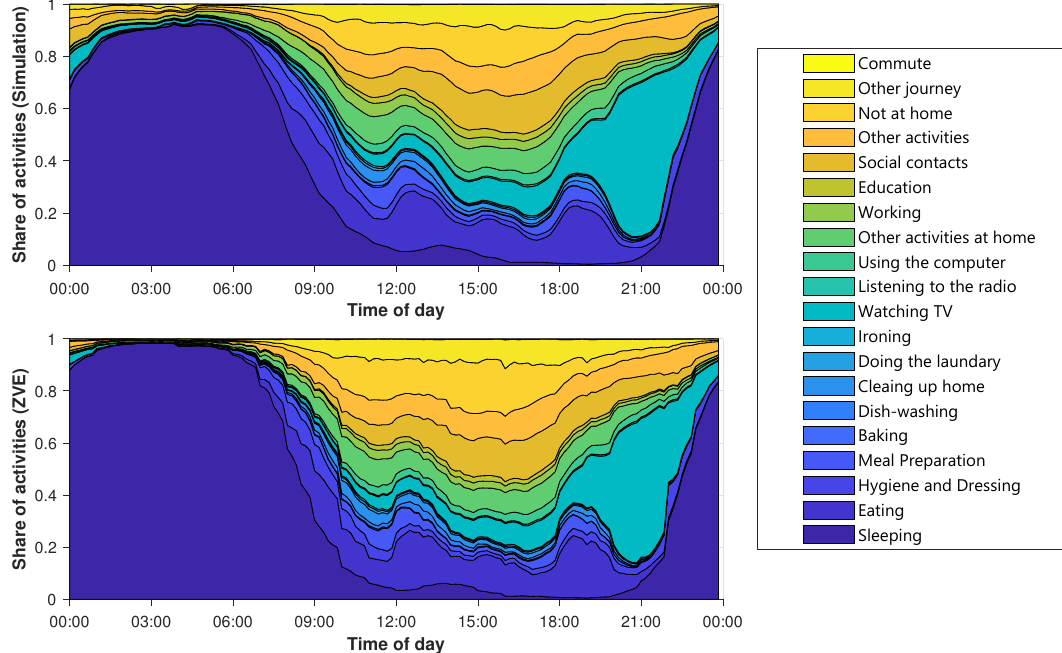
Figure 7. Average layered course of the activities for Sunday, above: simulation, below: